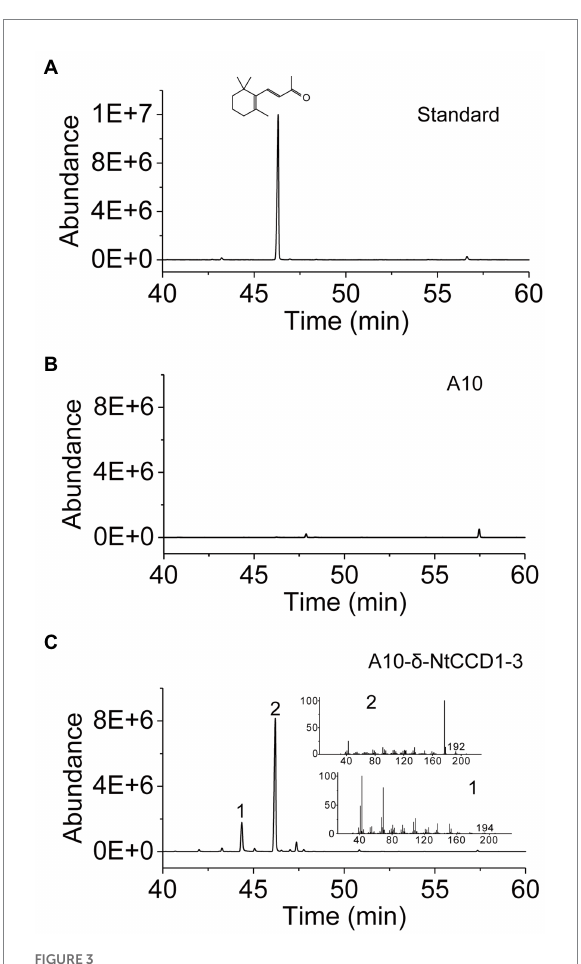
FIGURE 3 SPME-GC–MS analysis of authentic standard β -ionone (A) and volatile products in the strain A10 (B) as well as the 9# recombinant strain of A10- δ -NtCCD1-3 (C) . The compound 1 has an identical mass spectrum to that of the geranylacetone, and compound 2 has an identical mass spectrum and a chromatographic mobility identical to that of the authentic standard β -ionone.